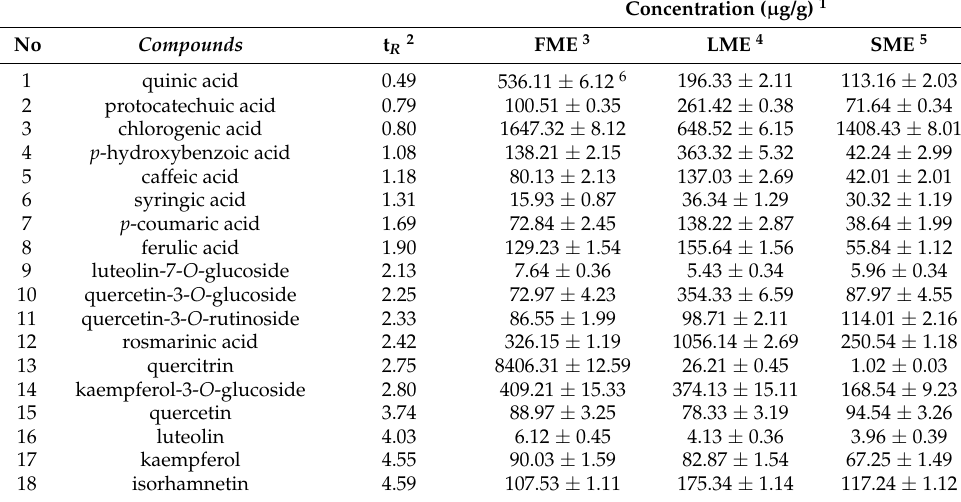
Concentration ( µ g/g)